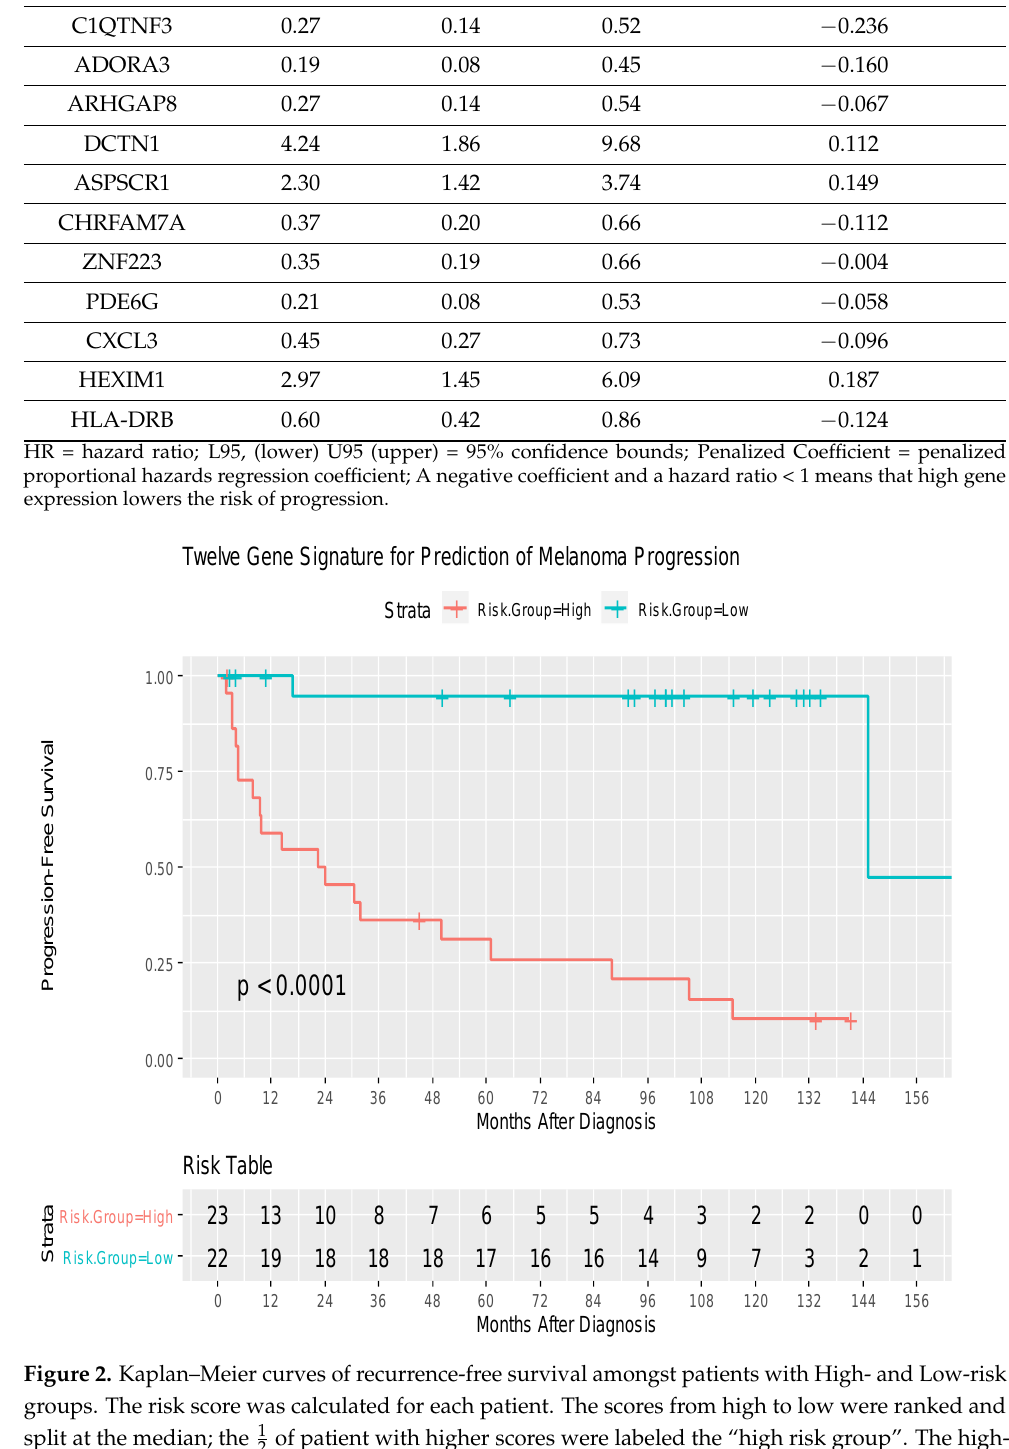
Table 2. 12 genes associated with recurrence-free survival with non-zero penalized coefficient (CLGN, C1QTNF3, ADORA3, ARHGAP8, DCTN1, ASPSCR1, CHRFAM7A, ZNF223, PDE6G, CXCL3, HEXIM1, HLA-DRB).